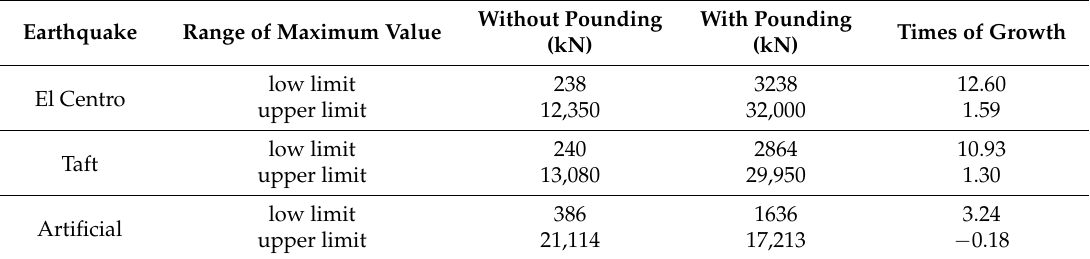
Table 3. Maximum values of story shear-force for model B. Figure 15. Story shear-force under different earthquakes (model B). ( a ) El Centro earthquake; ( b ) Taft earthquake; ( c ) Artificial excitation.